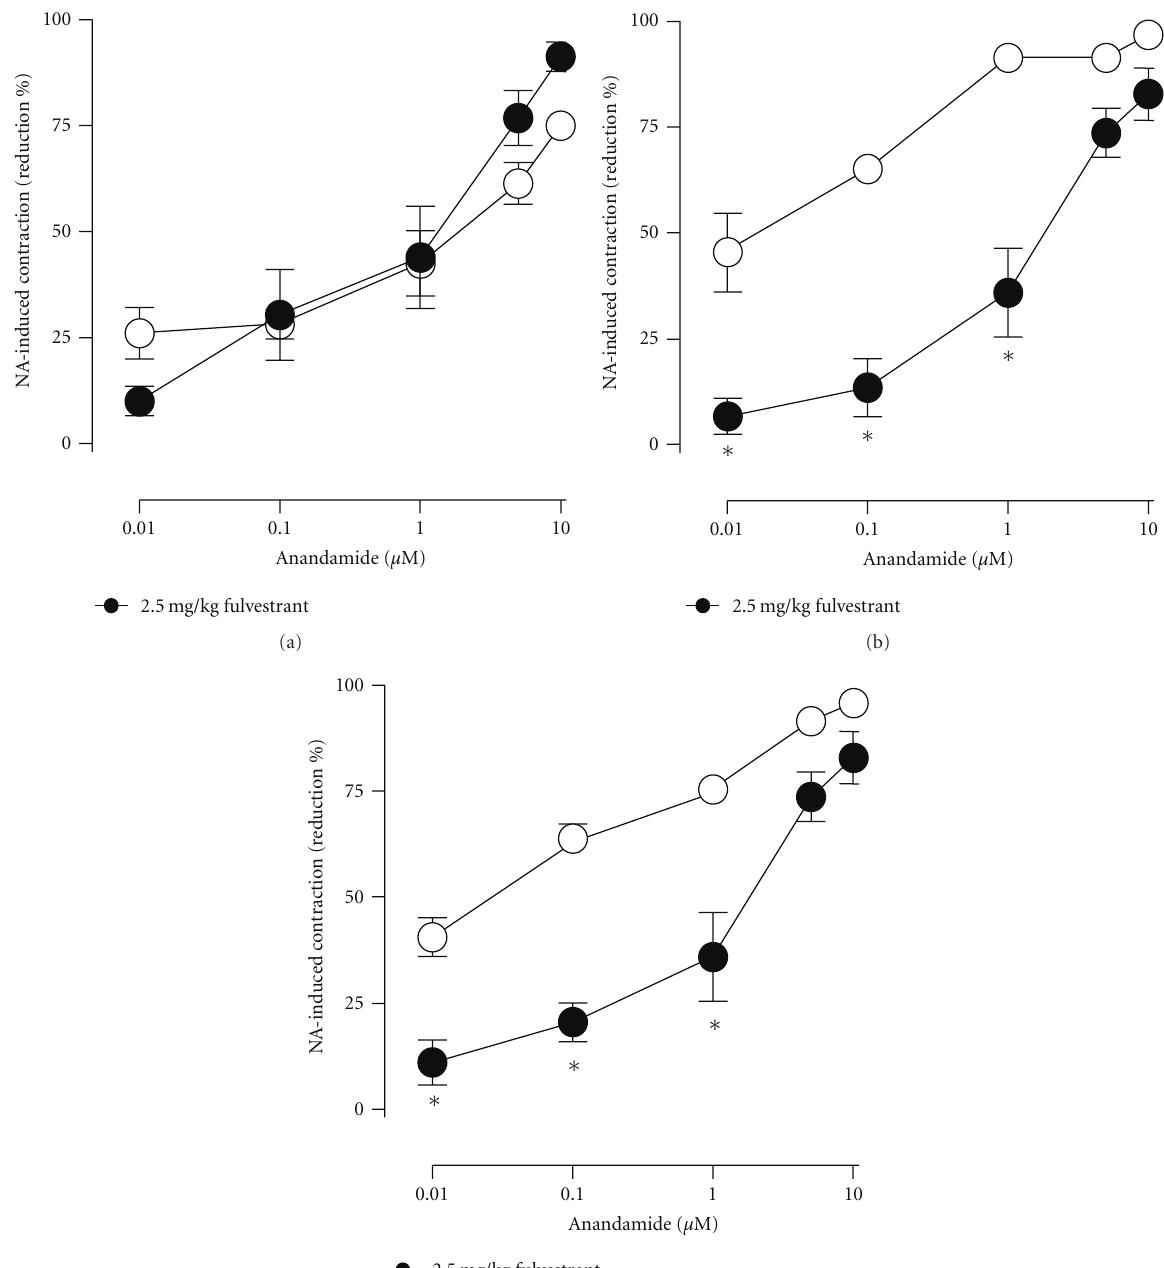
Figure 4: E ff ects of 3-day s.c. administration of 2.5 mg/kg of fulvestrant on the anandamide-induced reductions of contractile responses to NA in untreated (a), genisteintreated (10mg/kg; (b)), or daidzein-treated (20mg/kg; (c)) intact female rats. Either fulvestrant (filled circles) or its vehicle (open circles) were administered concomitantly with the corresponding phytoestrogen treatment. ∗ P < 0 . 05 when phytoestrogen-treated were compared against phytoestrogen plus fulvestrant-treated intact female rats.